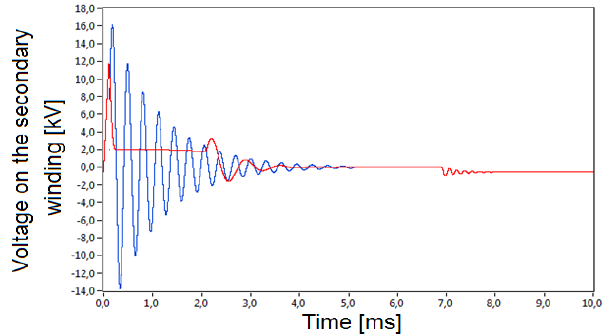
Fig. 4. Changes in the ignition voltage course on the secondary side in the event of a break in the spark plug circuit and no spark